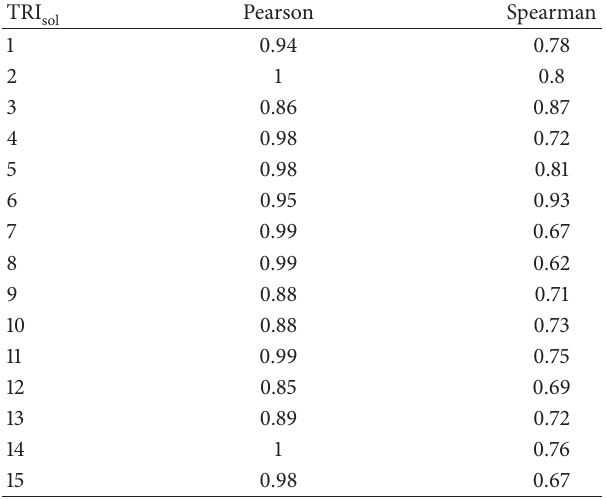
Table 11: GO analysis for tricluster TC 15 in Mouse GDS4442 Dataset.